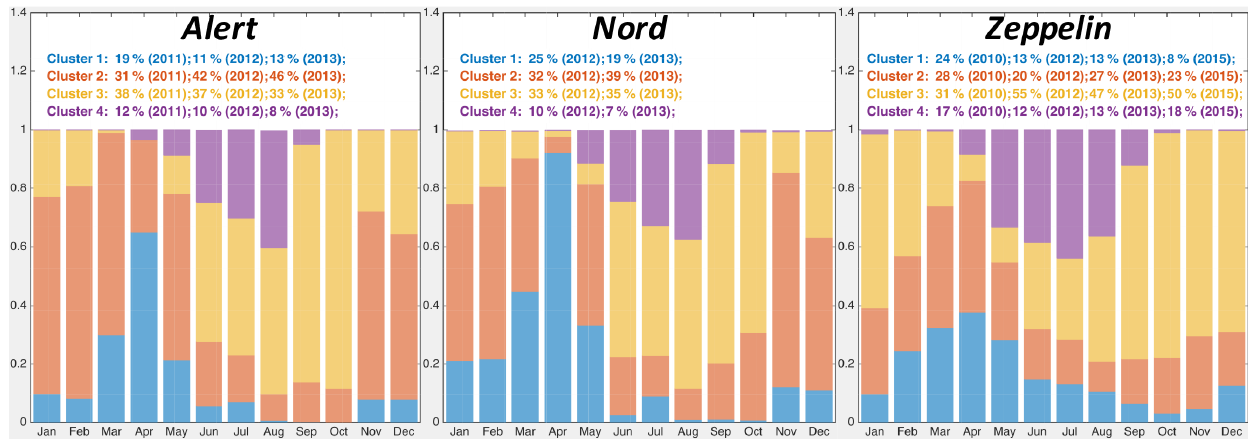
Figure 6. The monthly probability of cluster occurrence. The bars indicate the mean relative frequency of the four aerosol clusters within each month (weighted by their number of occurrences in each of the included years). The colour coding is the same as in Fig. 5. The percentages in the legend indicate the mean annual relative occurrence of each of the clusters, only for years that had a fair representation of all seasons (see Fig. 2). Tiksi and Barrow were not part of the cluster analysis due to their poorer data coverage and less representative wind-directional sampling (see Sect.